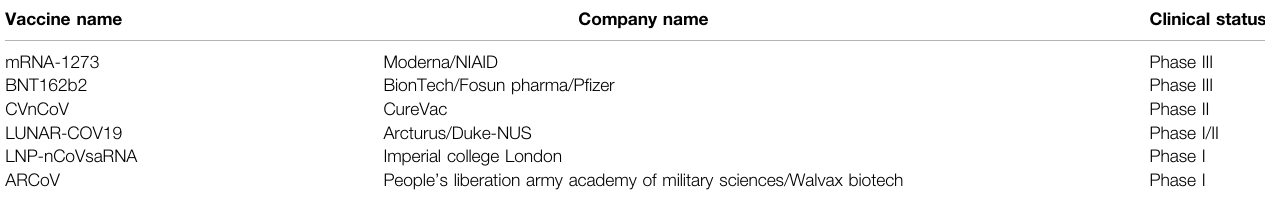
TABLE 3 | List of mRNA vaccines in various stages of clinical trials.